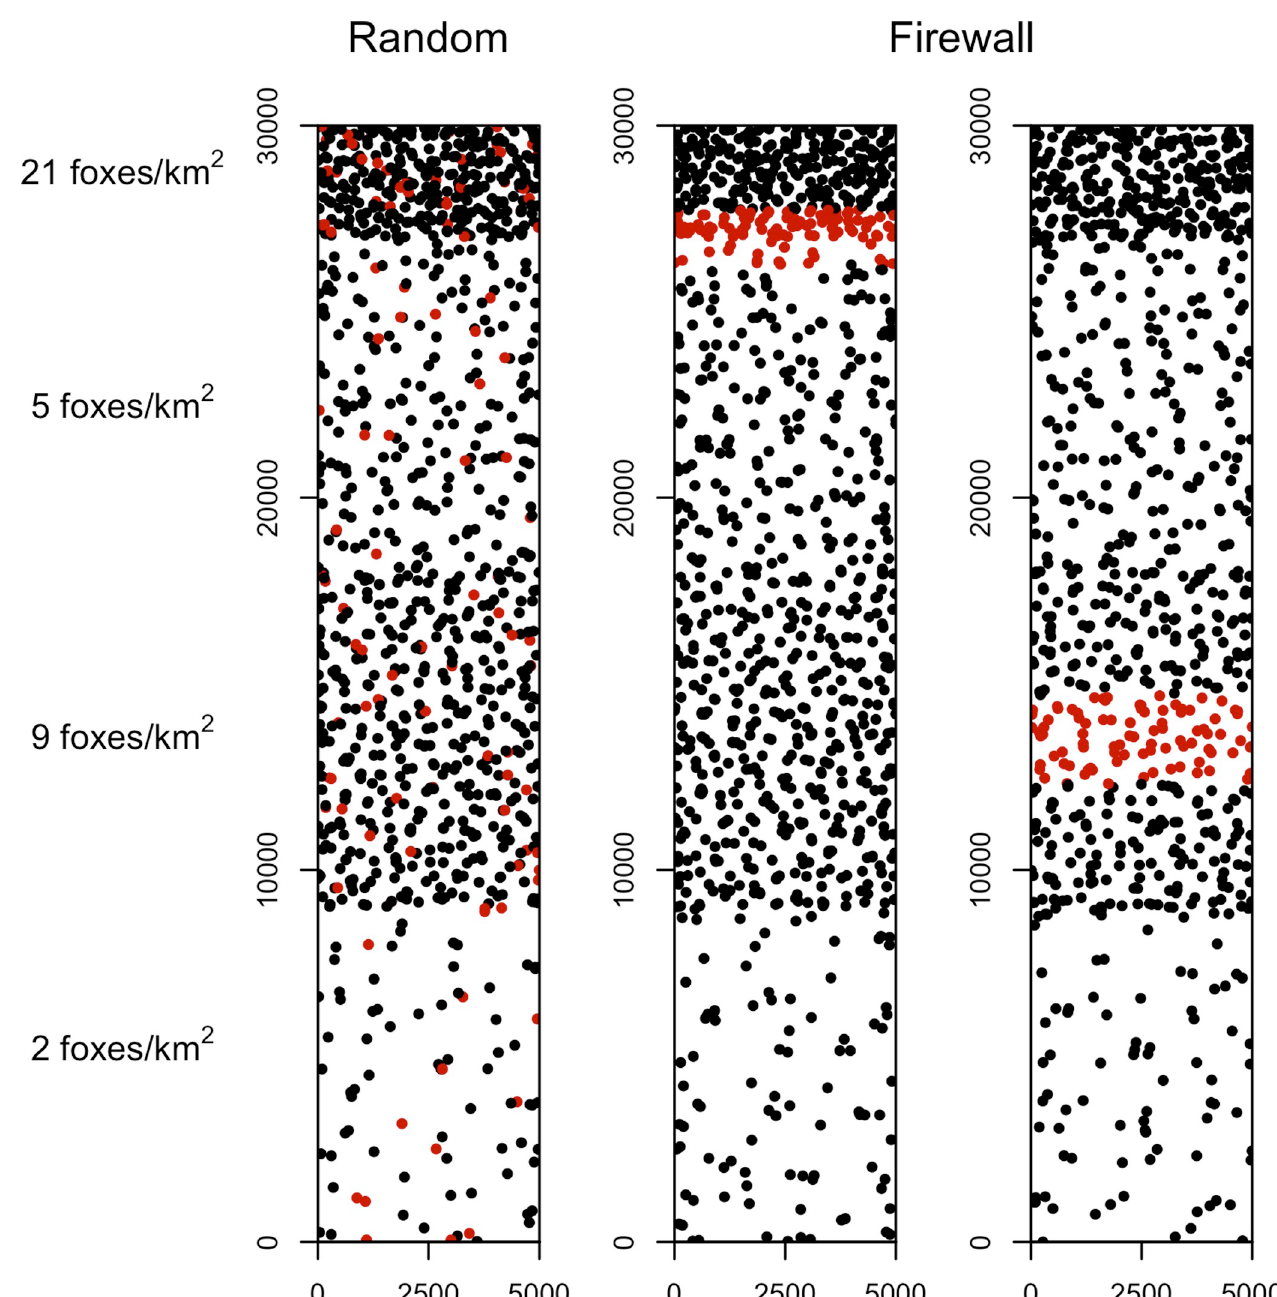
Fig 2. Maps of San Clemente Island as depicted by the rabies and canine distemper models, with dots representing the simulated home range center of each fox. Vaccinated individuals (red dots; 10% of the fox population) were distributed randomly across the island or in a firewall configuration located in a high or medium-high density of foxes. Fox densities within each section of the island represent the average across all model iterations. Scales are in meters.